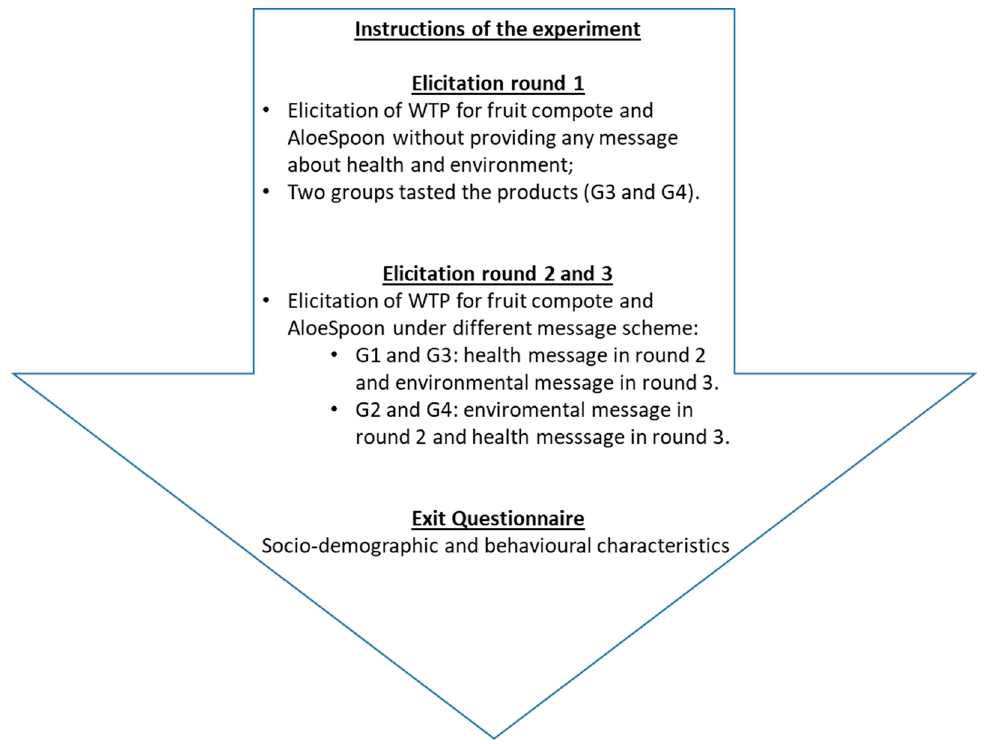
Figure 1. Timeline of the experiment.